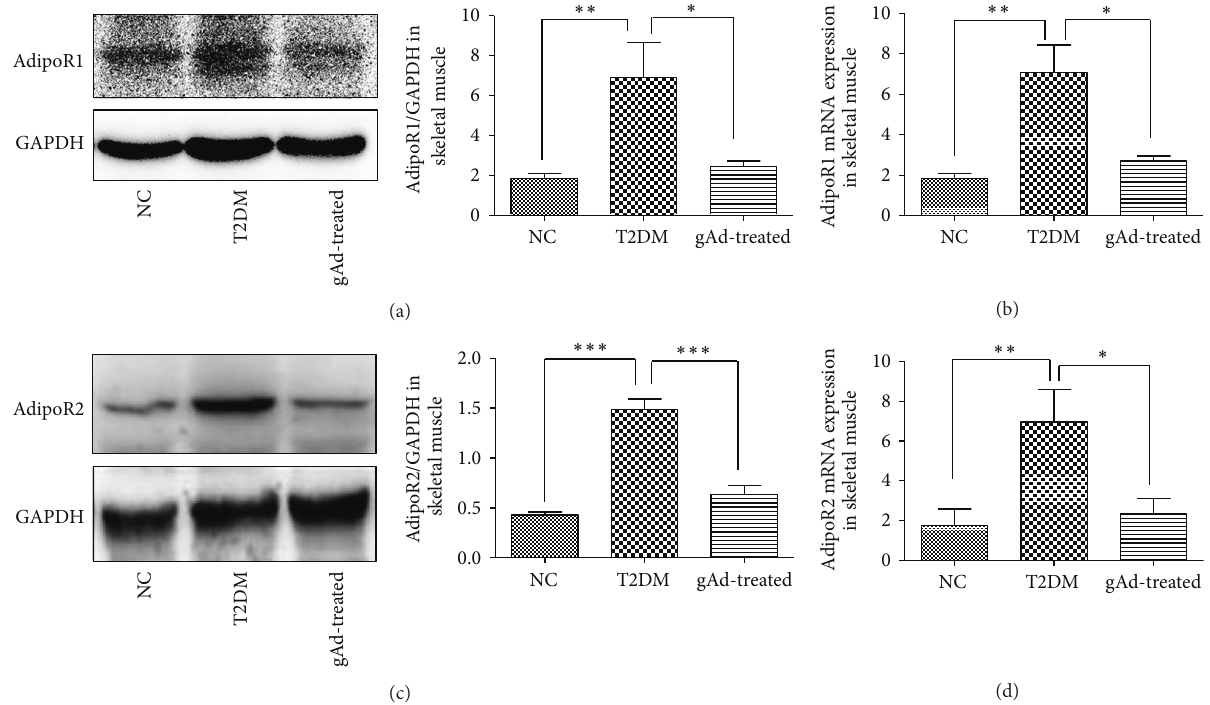
Figure 4: (a) Relative adipoR1 protein expression in skeletal muscle was determined through western blotting using GAPDH as a reference protein. (b) Relative adipoR1 mRNA expression in rat skeletal muscle. (c) Relative adipoR2 protein expression in skeletal muscle was determined through western blotting using GAPDH as a reference protein. (d) Relative adipoR2 mRNA expression in rat skeletal muscle. ∗ 𝑃 < 0.05 , ∗∗ 𝑃 < 0.01 , ∗∗∗ 𝑃 < 0.001 as compared to T2DM